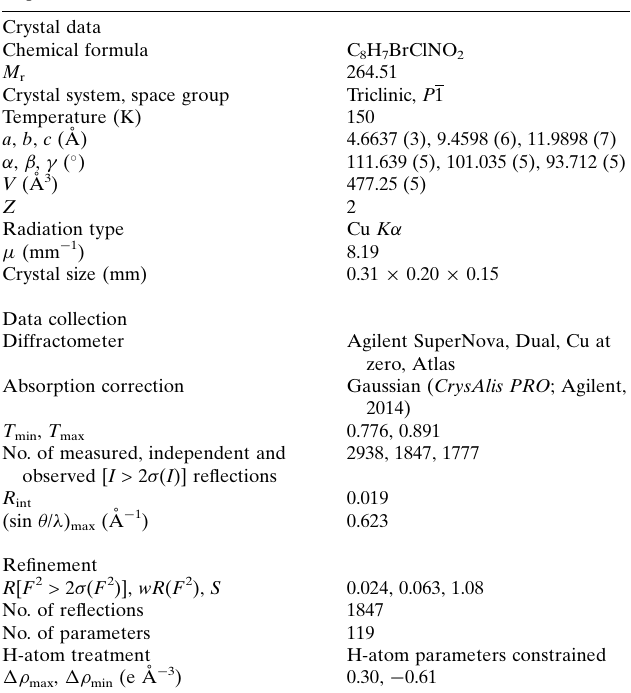
Table 2 Experimental details.